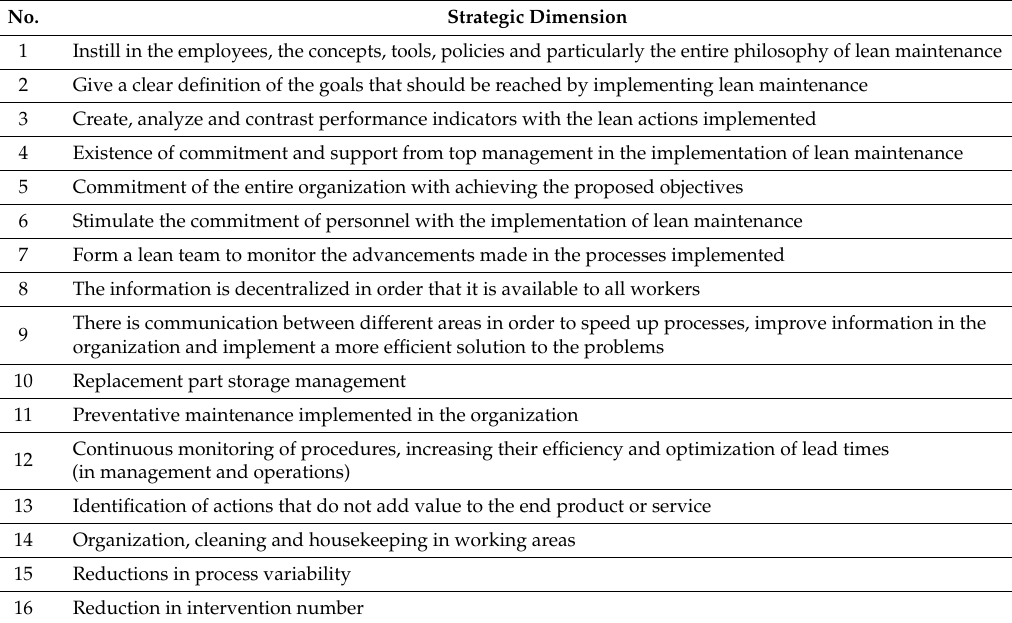
Table 4. Strategic dimensions used in